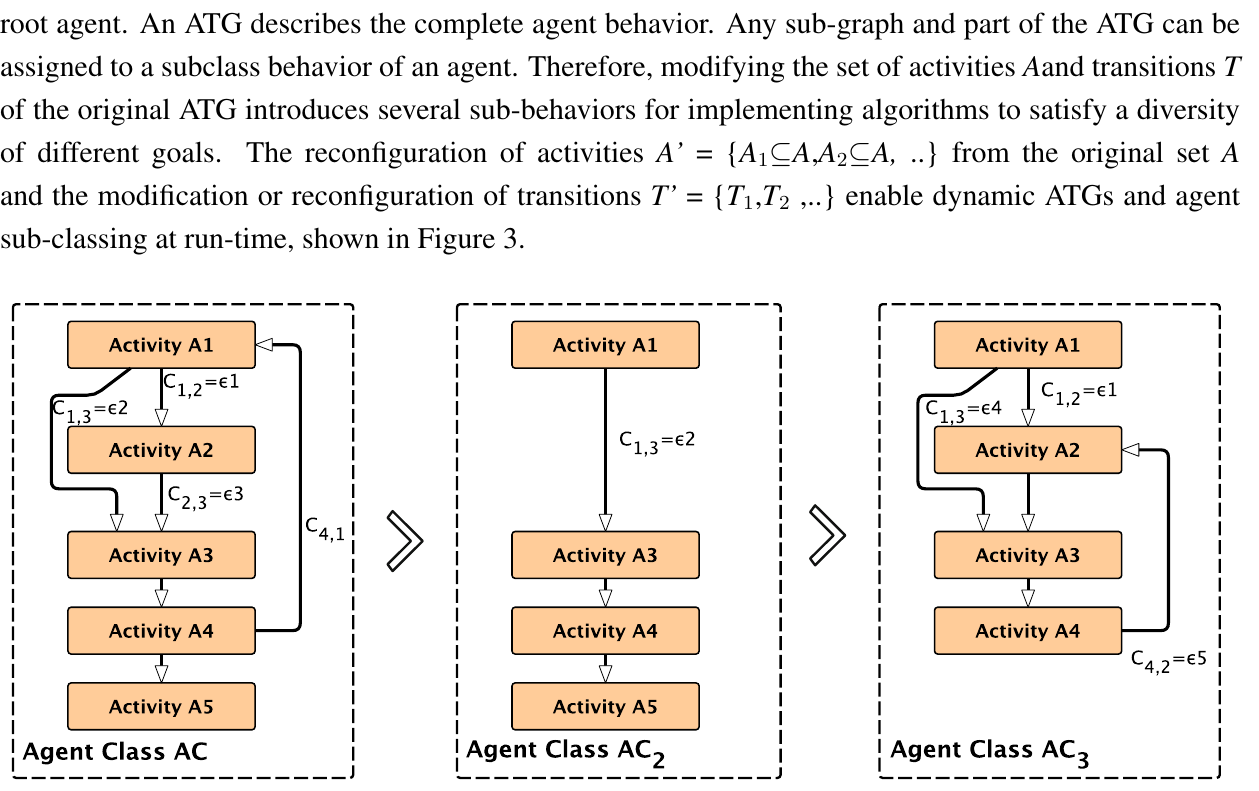
Figure 3. Dynamic activity-transition graph (ATG) transformation at run-time by modifying the set of transitions and activities, creating new agent (sub-)classes from an original root